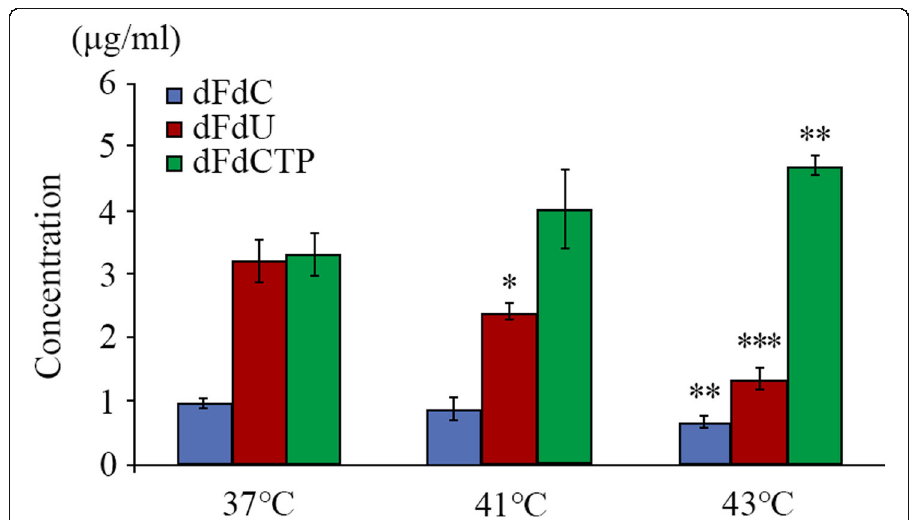
Fig. 5 Effects of hyperthermia on concentration changes in dFdC, dFdU and dFdCTP. Error bars indicate standard errors. n = 5, ** p < 0.05, ** p < 0.01, *** p <